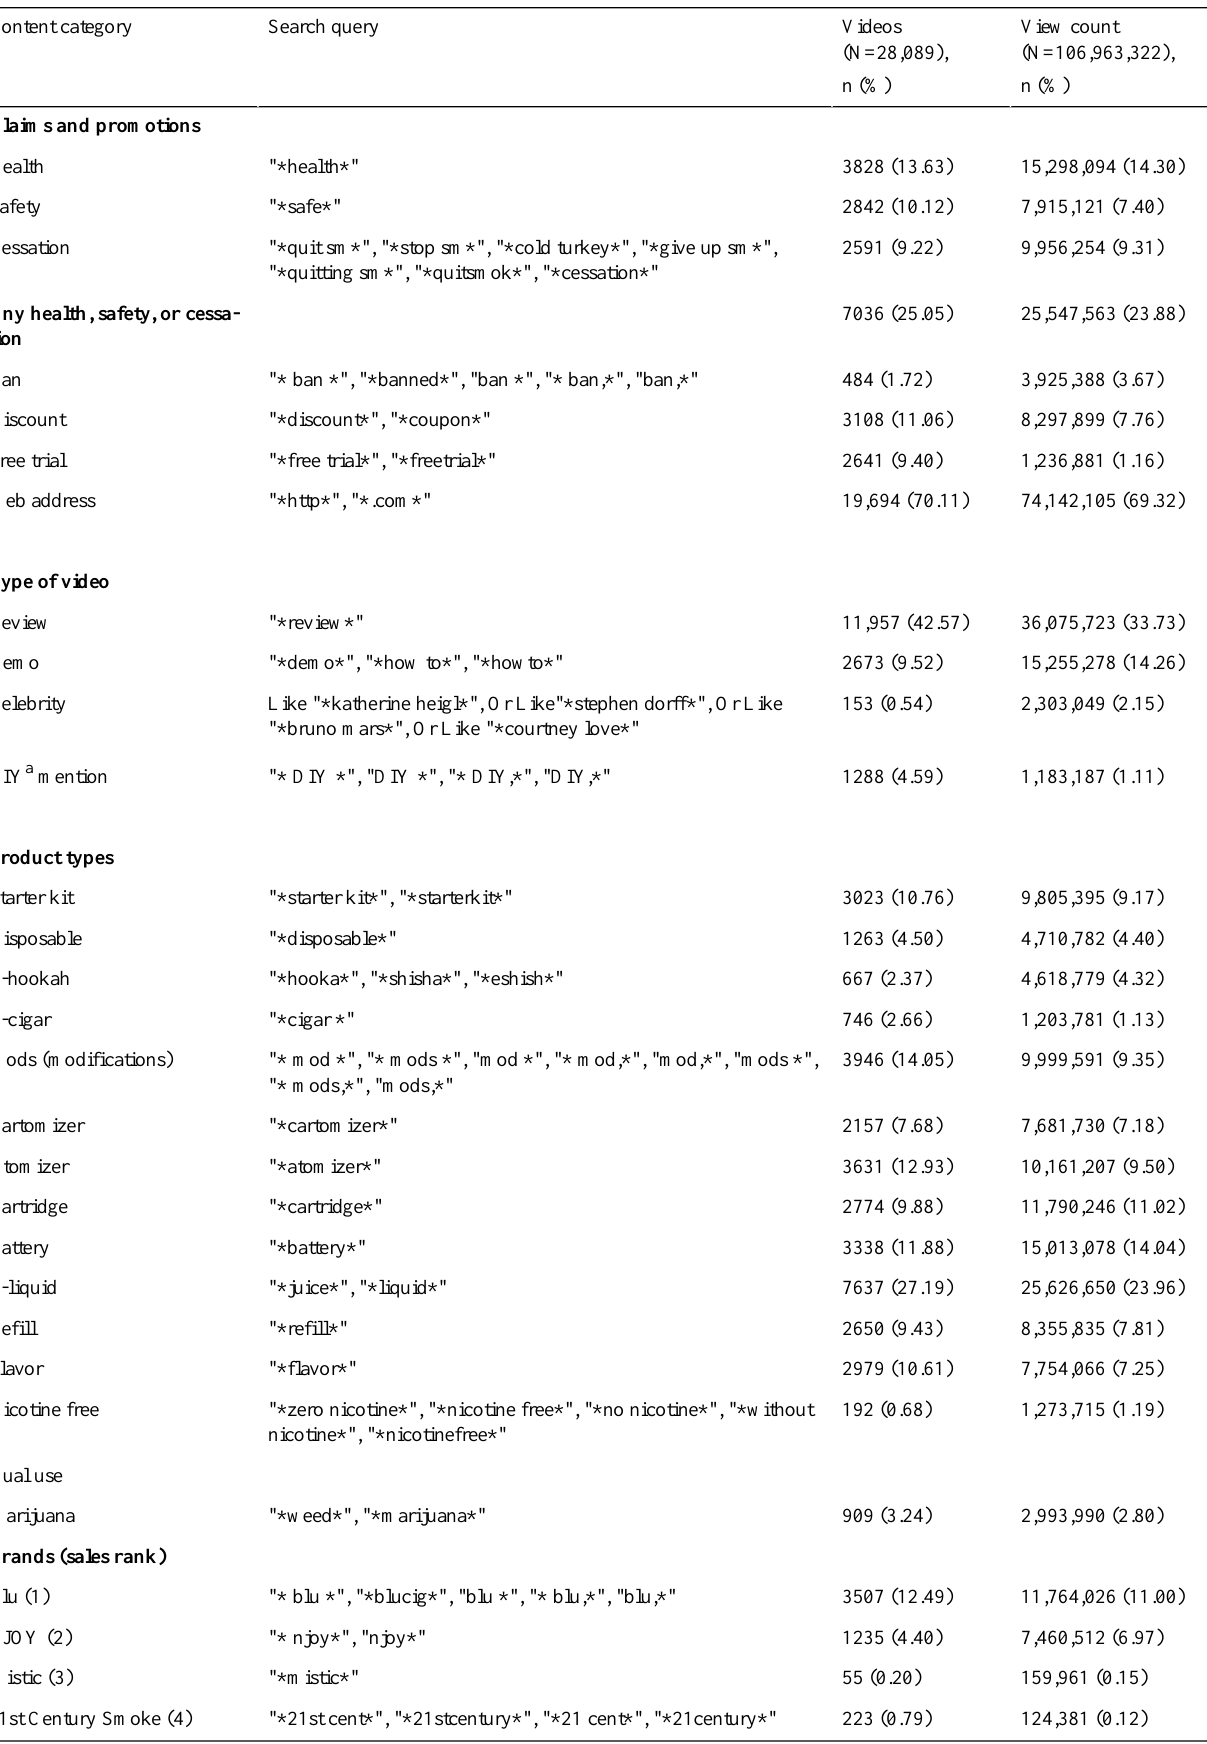
Table 3. Content of metadata for e-cigarette-related videos on YouTube as of June 30,